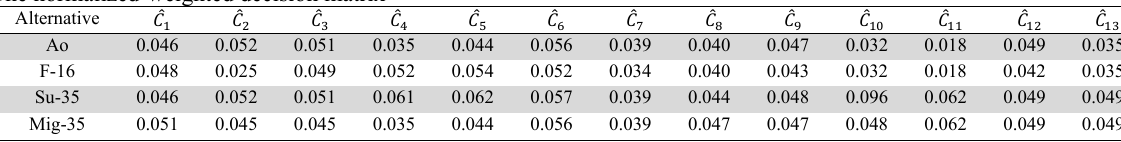
The normalized-weighted decision matrix Alternative